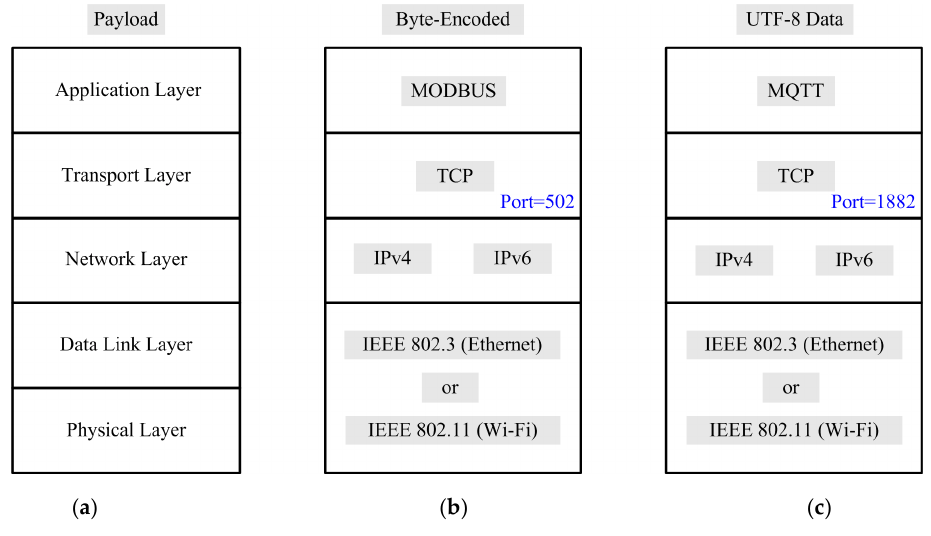
Figure 5. The IEEE model ( a ); compared to the MODBUS TCP ( b ); and the MQTT ( c ).